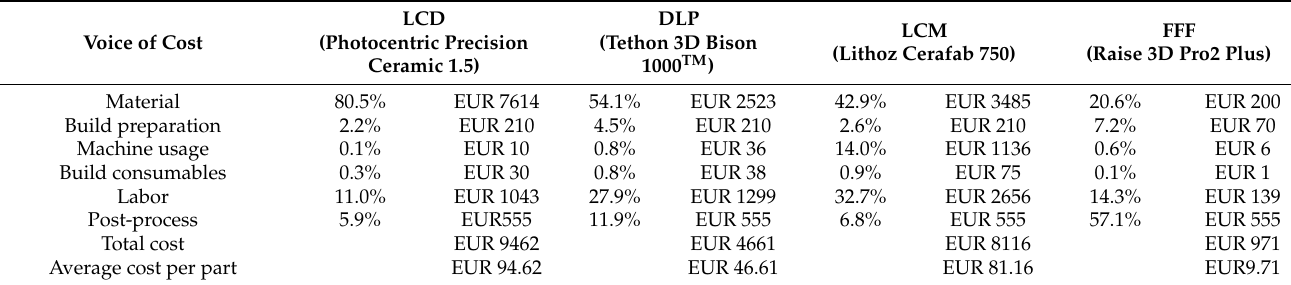
Figure 8. FFF alumina: ( a ) green part; ( b ) sintered part. Table 7. Cost model of LCD, DLP, LCM, and FFF printing of alumina.